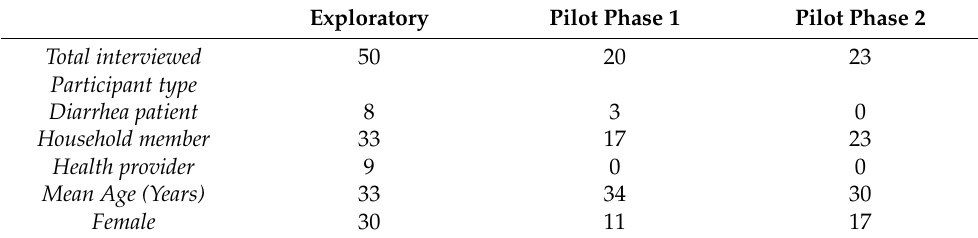
Table 1. Demographic characteristics of